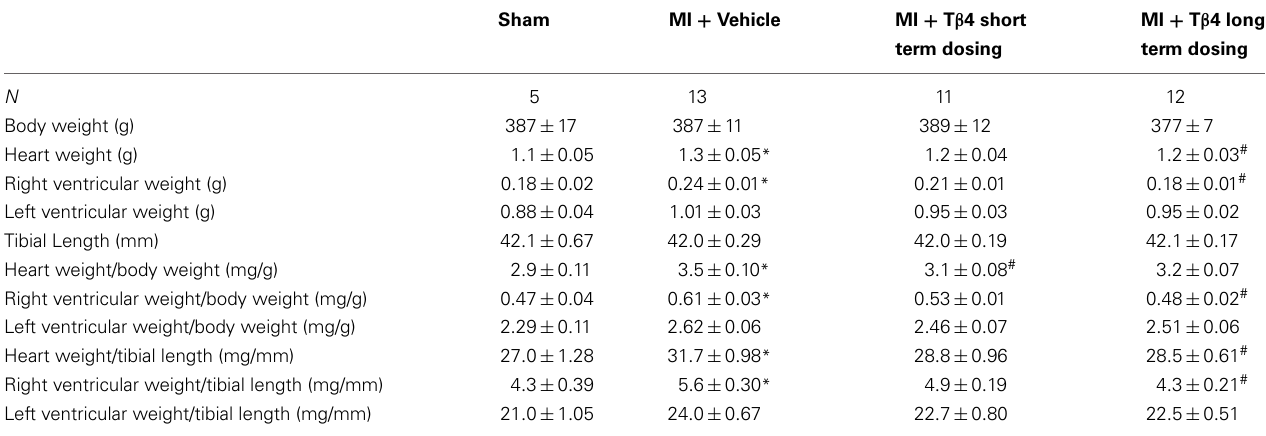
T β 4-short term dosing rats were treated with 5mg/kg/day T β 4 IP for 3 days post-MI, with the first dose administered immediately post-MI. T β 4-long term dosing rats were treated with 5mg/kg/day T β 4 IP for the first 3 days, then every third day up to the end of the study on day 28, with the first dose administered immediately post-MI. Data are mean ± s.e.m. # p < 0.05 MI + Vehicle vs. MI + T β 4 group. * p < 0.05 Sham vs. MI +